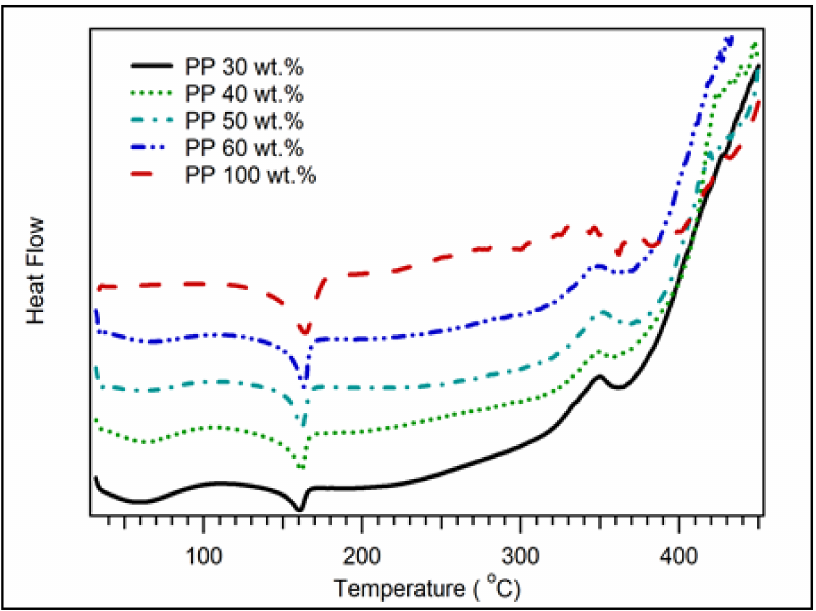
Figure 5. DSC of coconut shell biocomposite for various PP compositions with 200 mesh of coconut shell particles. Table 3. DSC data of coconut shell biocomposite for various PP compositions. PP Composition